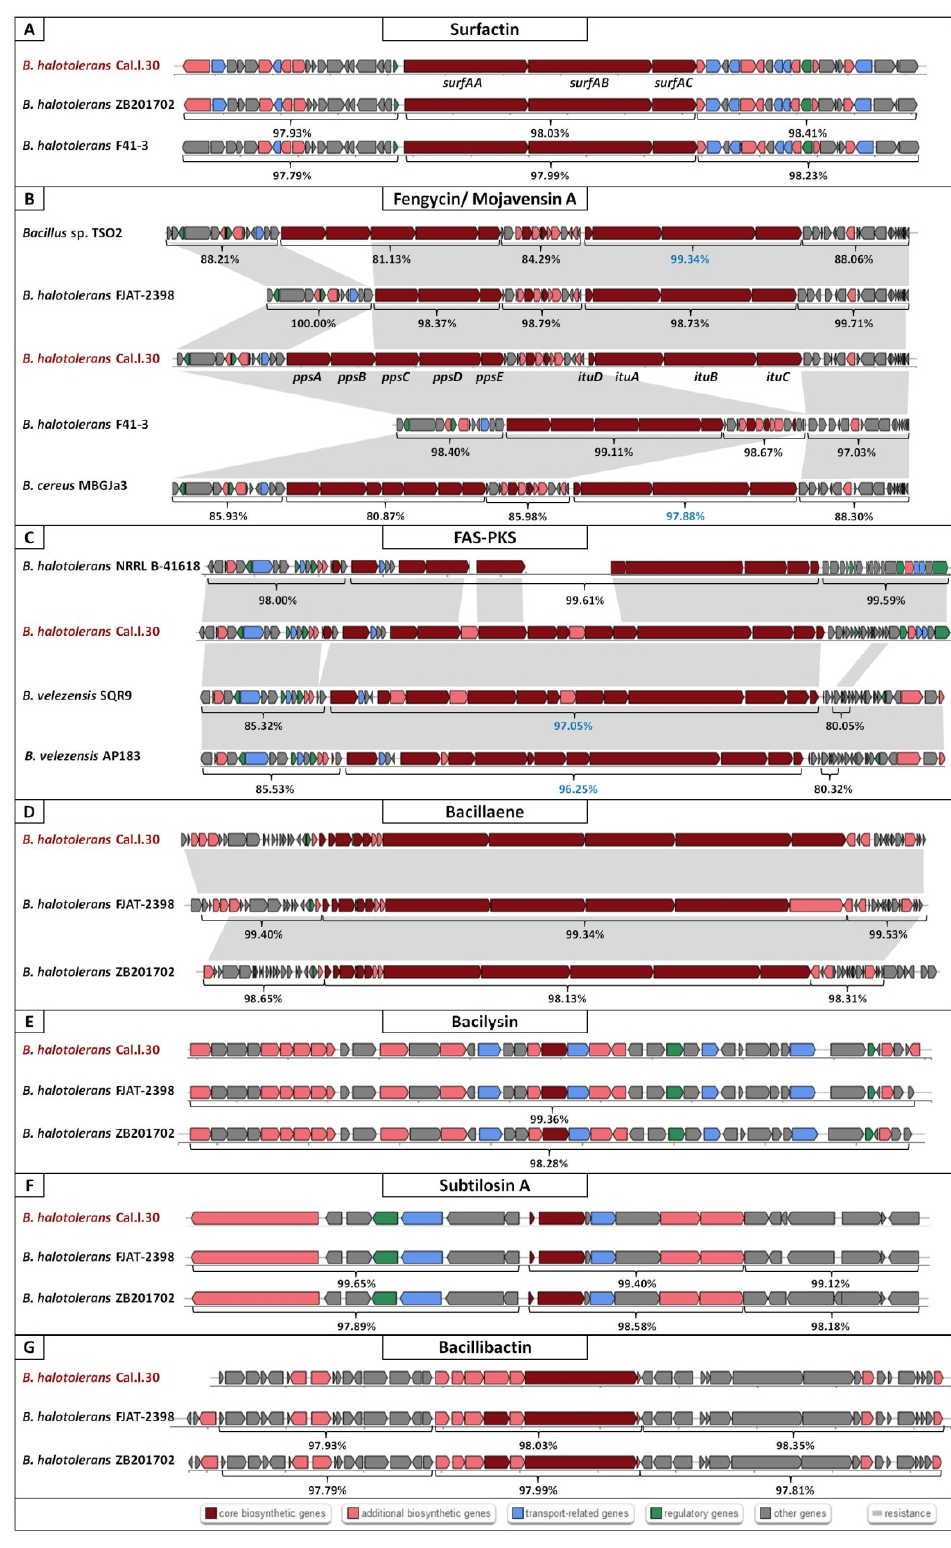
Figure 5. Secondary metabolite biosynthetic gene clusters (BGCs) of Bacillus halotolerans Cal.l.30 using antiSMASH. Eight BGCs for the possible production of secondary metabolites: ( A ) Surfactin, ( B ) Mojavensin A/ Fengycin, ( C ) FAS-PKS, ( D ) Bacillaene, ( E ) Bacilysin, ( F ) Subtilosin A and ( G ) Bacil- libactin were predicted. Genes with different color represent different functions as described in the colored blocks.